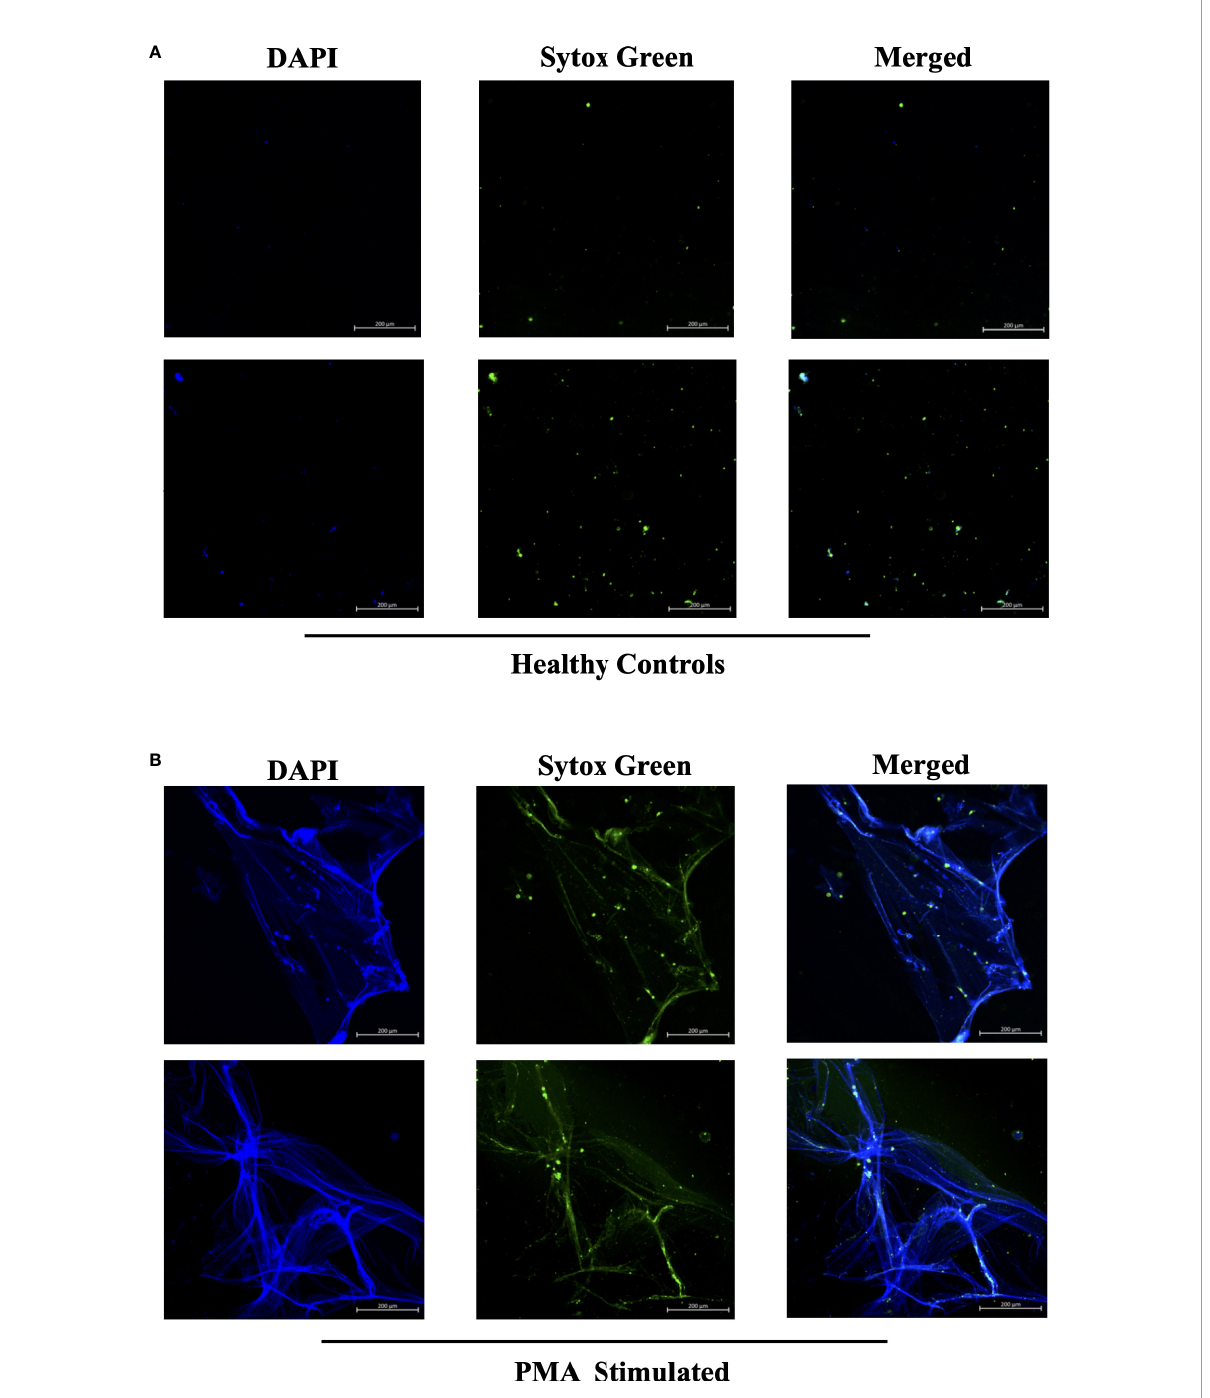
FIGURE 3 Sytox Green and DAPI staining of PMA stimulated and unstimulated samples to con fi rm presence of circulating NETs. Plasma smeared poly-l- lysine slides were prepared and stained with Sytox Green and DAPI for (A) unstimulated healthy controls and (B) PMA stimulated controls. Overlap of DAPI and Sytox Green channels con fi rm presence of circulating NETs in PMA stimulated donors. Individual merged images represent separate donors (n=4). All images were taken on ZEISS Confocal M880 at 20x objective. Set scale